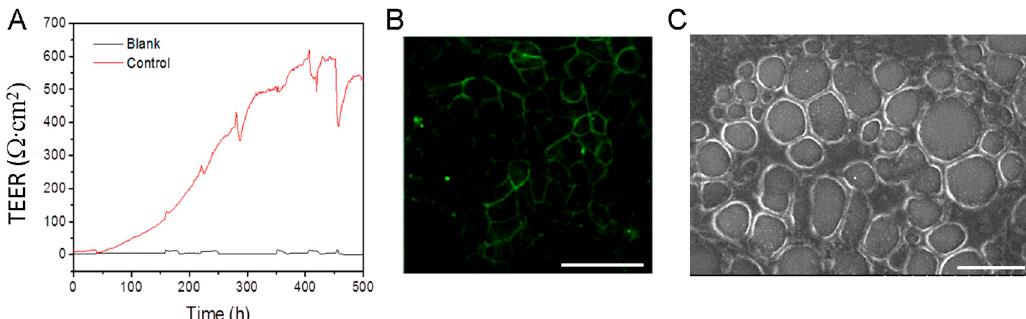
Figure 3. Formation of Caco-2 cell monolayer. ( A ) Continuous transepithelial electrical resistance (TEER) analysis of Caco-2 cell monolayer over 21 d. ( B ) Caco-2 cell monolayer formed after 21 d of culture. Green is immunofluorescence stained ZO-1 protein (tight junction protein). Scale bar is 40 µm. ( C ) SEM image of Caco-2 cell monolayer. Scale bar is 20 µm.